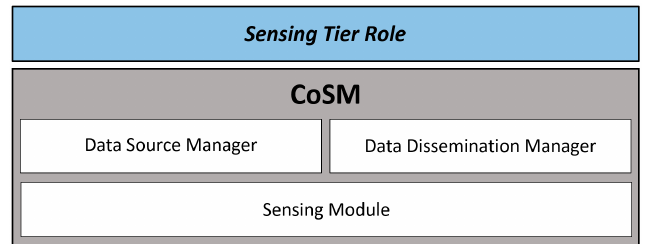
Figure 5. Structure of the Collaborative Sensing Module (CoSM).